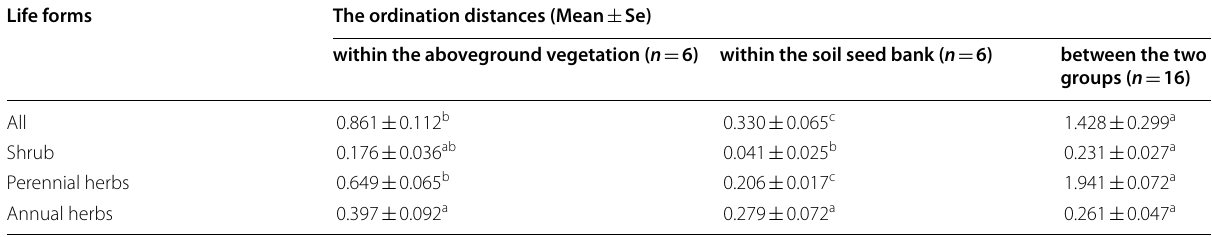
Within each row, different letters represent significant differences within the soil seed bank, the aboveground vegetation and between the two groups for different life form species according to a post-hoc HSD tests at p < 0.05 level